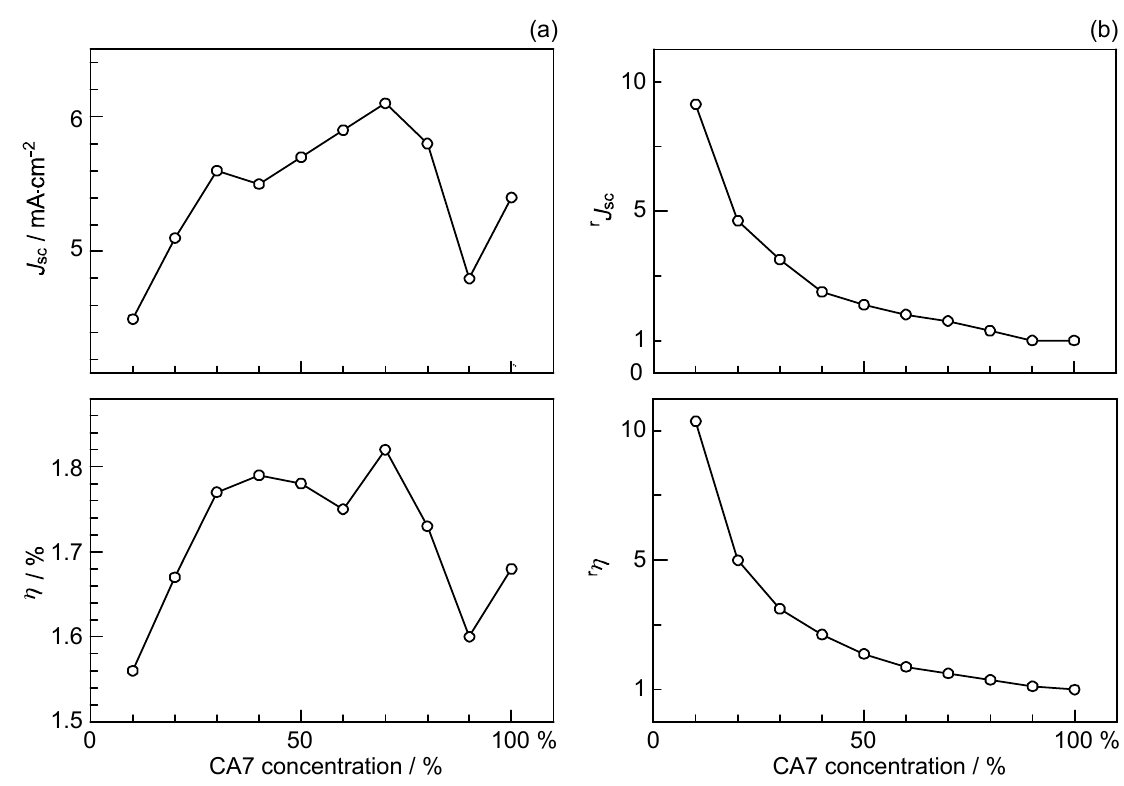
) Figure 10. Effects of dilution with a spacer (deoxycholic acid) on ( a ) the photocurrent ( J sc and conversion efficiency ( η ) and ( b ) the relative photocurrent ( r J ) and conversion sc efficiency ( r η ) of CA7-sensitized solar cells. To obtain r J (X) at a mole fraction X, for sc (X) was scaled against concentration, and, then, a ratio was taken in reference example, J sc to the value with no dilution. Thus, r J (X) = J (X)/X/ J (X = 1) and r η (X) = η (X)/X/ η (X = 1) sc sc sc (reprinted from [3] with permission of